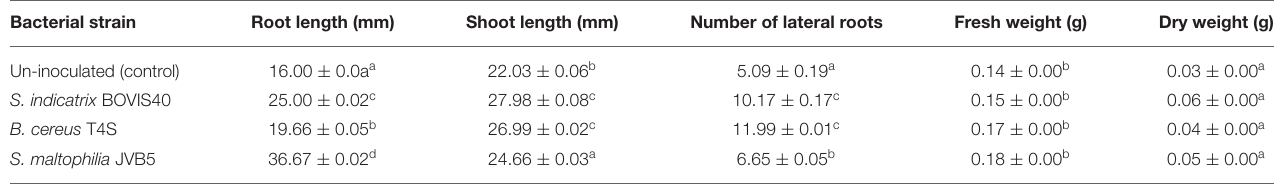
TABLE 5 | Growth parameters of inoculated and un-inoculated sunflower seedlings. Bacterial strain Root length (mm) Un-inoculated